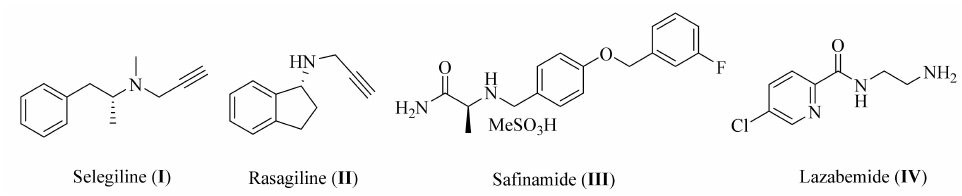
Figure 1. Chemical structure of some well-known MAO-B